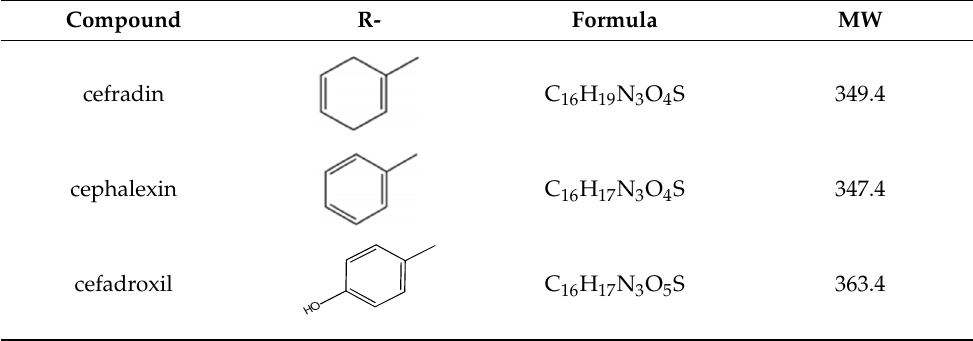
Figure 1. Cephalosporin molecular structure. Table 1. Molecular information for cefradin, cephalexin, and cefadroxil. Compound